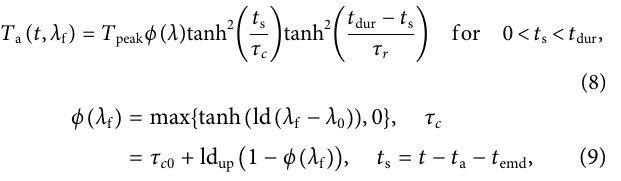
TABLE 1 | Input parameters for the electromechanical computational model. Parameter Value Unit Description Passive biomechanics ϱ 0